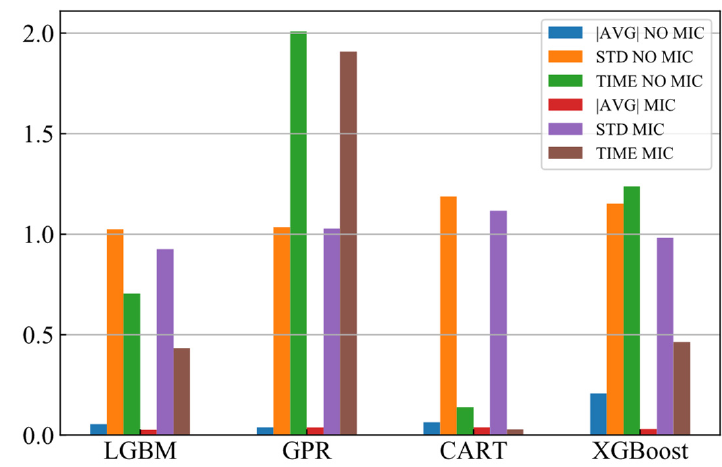
Figure 10. Average evaluation metrics under two conditions.